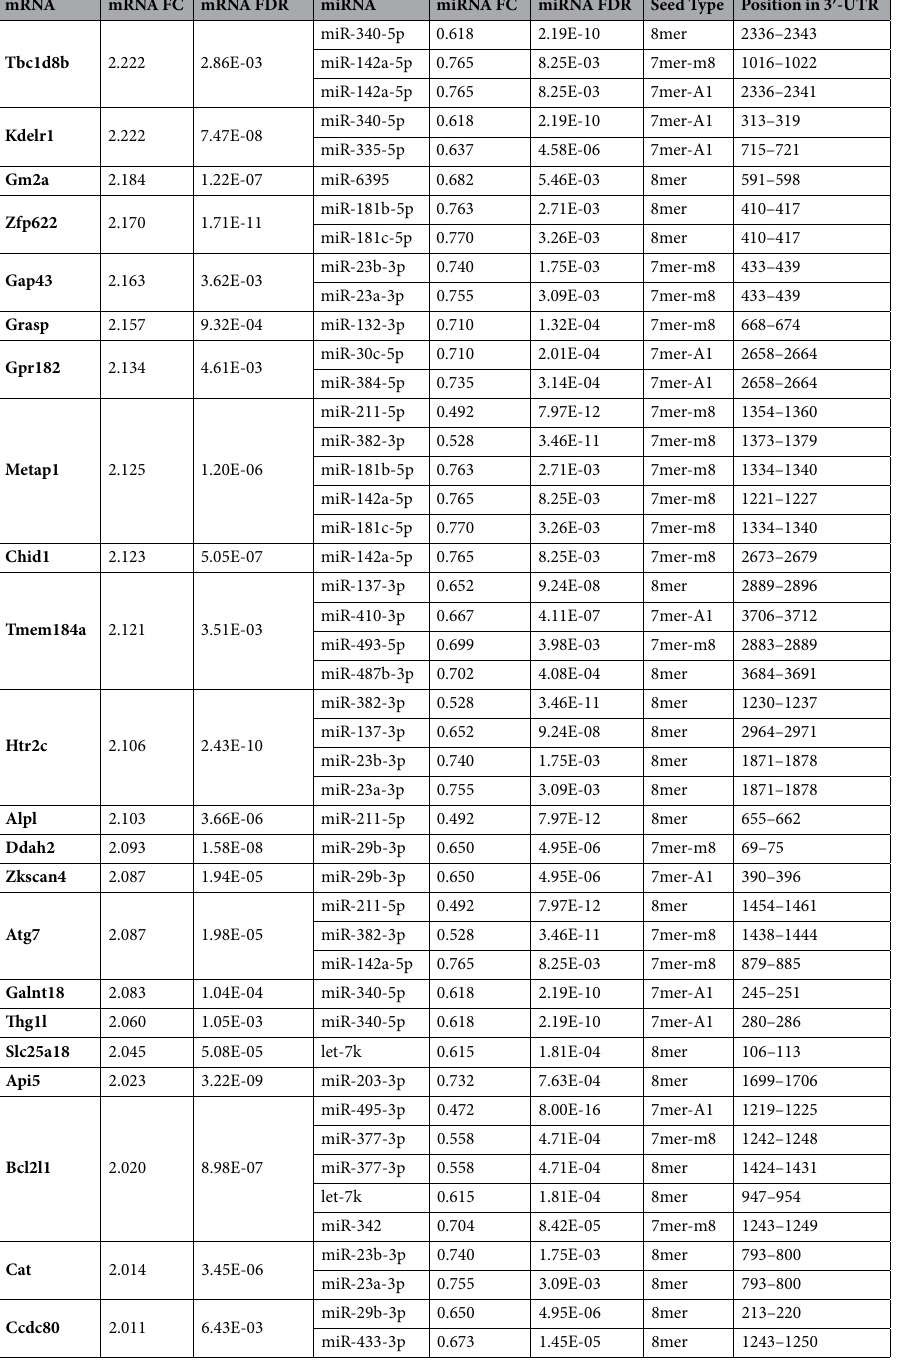
Table 2. Predicted miRNA targets differentially expressed in the MHb during acute nicotine withdrawal. TargetScan Mouse 7.1 predicted conserved MREs within the 3 ′ -UTRs of a subset of mRNAs differentially expressed in the MHb of NAWD mice compared to TA controls. miRNAs conserved in vertebrates and mammals that were inversely expressed (FDR < 0.01) and predicted to target these MREs are listed. Only mRNAs with a FC > 2 and an FDR < 0.01 were included in target prediction analysis. Seed type of the predicted MRE and its position within the 3 ′ -UTR are